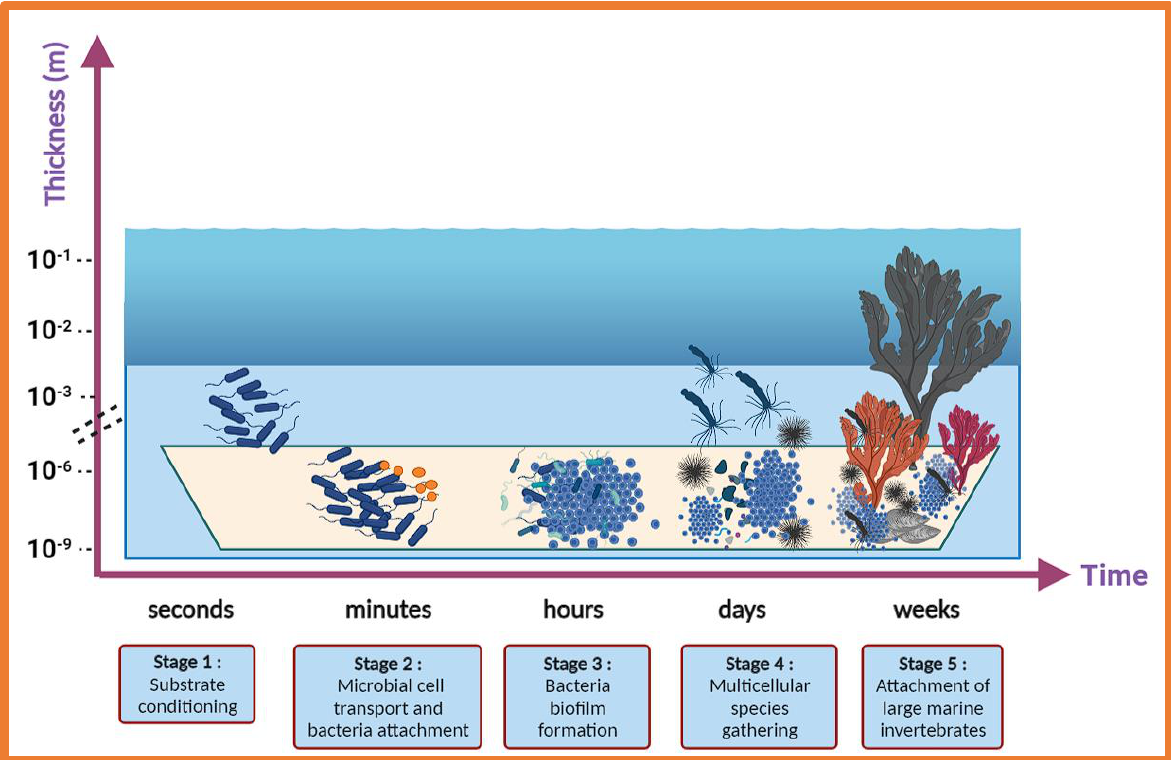
Figure 2. Five stages of typical marine biofouling: (1) substrate conditioning, (2) transport of micro- bial cells to the surface and attachment of bacteria on the surface, (3) formation of a microbial bio- film, (4) development of a complex community, and (5) attachment of larger marine invertebrates.